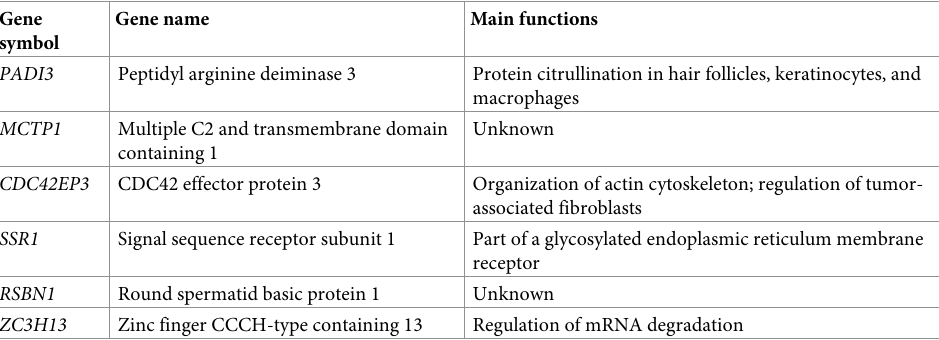
Table 3. Main functions of genes differentially expressed between non-MSL TN-IBC and non-MSL TN-non-IBC in both the Vanderbilt and Insight TNBCtype